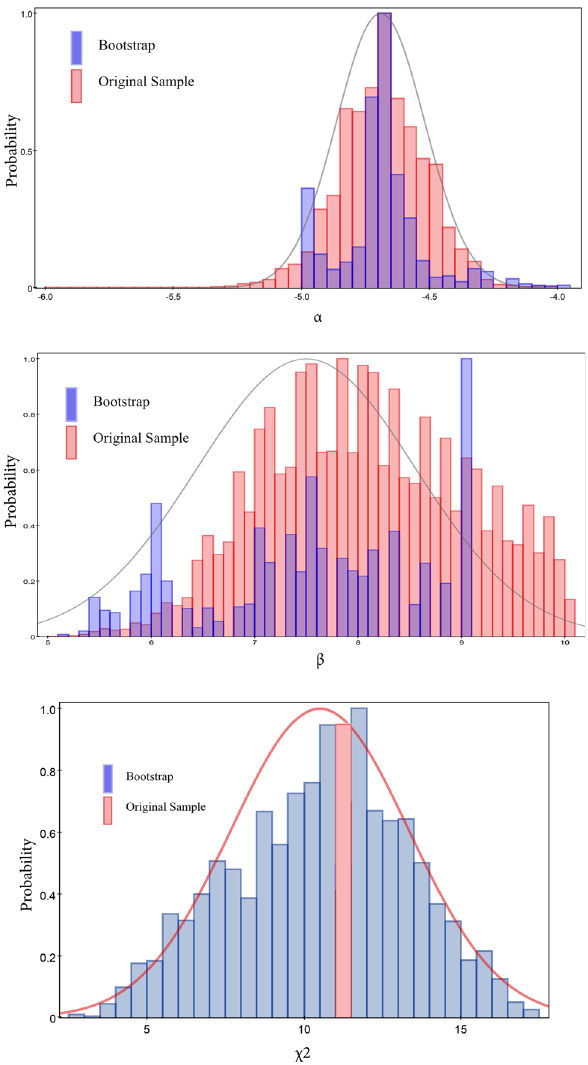
Fig. 7 The Histogram of parameters α,β and χ 2 original sample